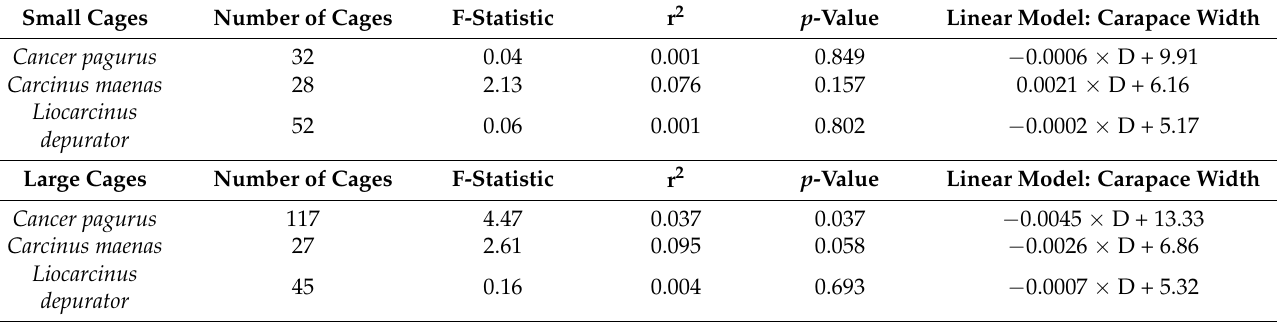
Table 4. Results of the linear models with carapace width of the three most abundant decapod species as a function of distance to the closest ecological foundation (=D) for the two cage